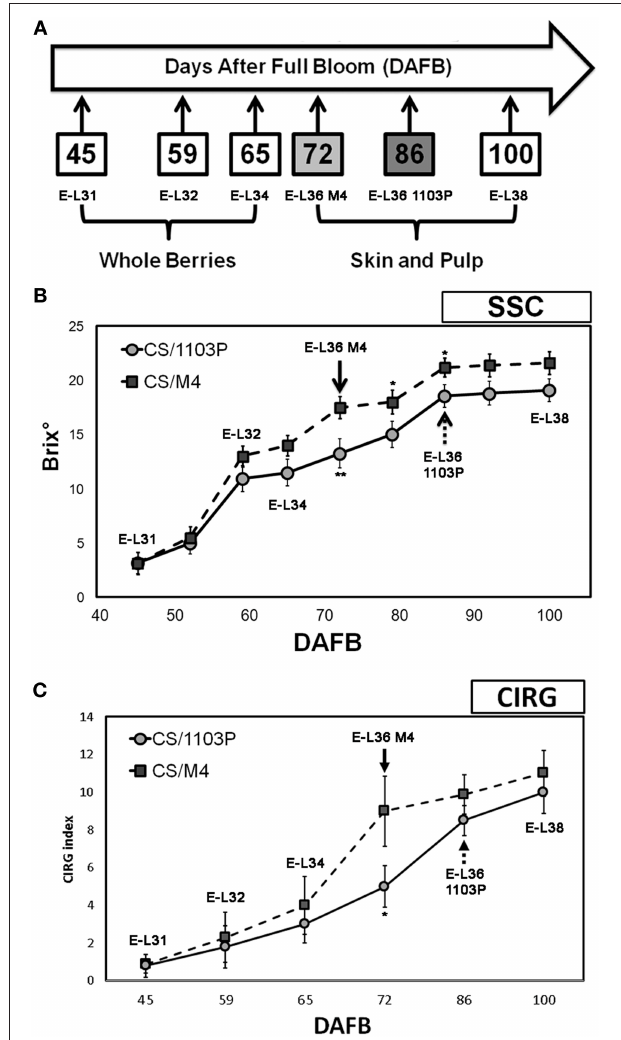
FIGURE 1 | (A) Schematic representation of the experimental trial. Samplings of berries grown in both 1103P/CS and M4/CS graft combinations were performed at 45 (E-L31), 59 (E-L32), 65 (E-L34), 72 (E-L36 M4), 86 (E-L36 1103P), and 100 (E-L38) DAFB. (B) Soluble solids content in CS/M4 (squares) and CS/1103P (circles) throughout fruit development. (C) CIRG values of CS/M4 (square) and CS/1103P (circle) graft combinations throughout fruit development. Bars represent the SD of 100 berries. CS/M4 and CS/1103P data from samples collected at the same DAFB were statistically treated using Student’s t -test ( * P < 0.05 ; ** P < 0.01